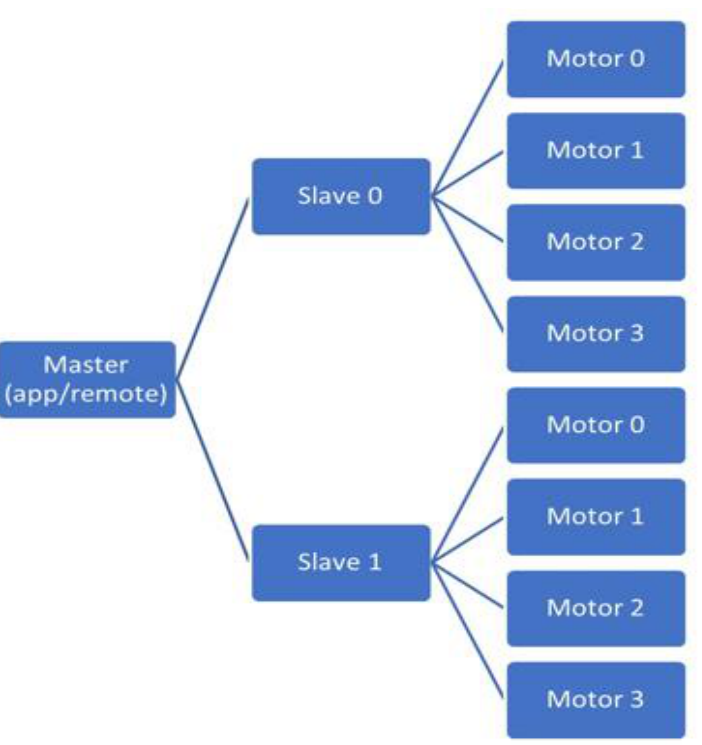
Figure 3. FoVi communication hierarchy. The “master” (app or remote) communicates to two “slave” devices: one in the upper arm sleeve and the other in the forearm sleeve. Each of these “slaves” in turn control up to four focal vibration motor pods.